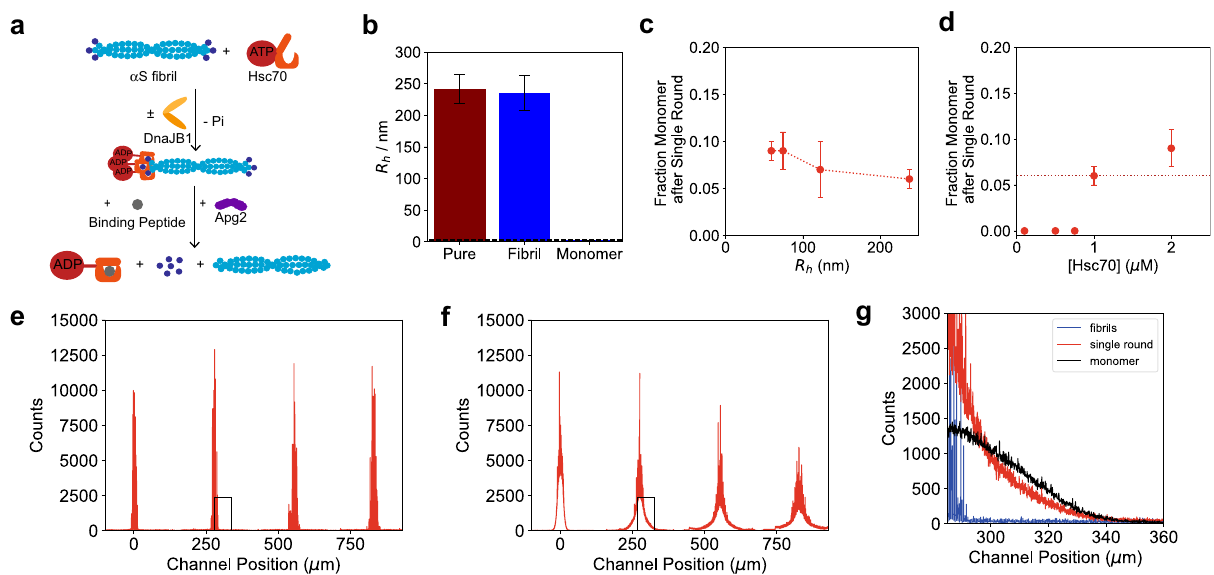
Fig. 4 Single round disaggregation experiments. a To measure the outcome of a single disaggregation round, α S fi brils (2 µ M monomer equivalent) were incubated with Hsc70 and DnaJB1. Subsequently, a 200-fold molar excess of Hsc70-binding peptide GSGNRLLLTG was added, to block Hsc70 re-binding to fi brils. b Outcome of a single disaggregation round, as measured by epi fl uorescence detection. Two species were detectable, the larger of which had a similar size to the initial fi bril, the second of which had the size of monomer. Red represents pure fi brils, blue the outcome after a single disaggregation round. c Fraction of monomer generated as a function of fi bril length at constant α S concentration, corresponding to an increased number of fi bril ends. Shorter fi brils lead to more monomer release per single disaggregation round than longer fi brils, whereby this effect plateaus for fi brils longer than 100 nm. d Fraction of monomer measured at different Hsc70 concentrations. No disaggregation took place for Hsc70 concentrations below 1 µ M, suggesting that there is a critical Hsc70 concentration required for ef fi cient disaggregation. Data in b – d are represented as mean ± standard deviation of n = 3 independent experiments. e Diffusion pro fi le for confocal scanning across the micro fl uidic channel for pure α S fi brils. The pro fi le does hardly broaden, as expected for a large amyloid fi bril. f Diffusion pro fi le for confocal scanning across the micro fl uidic channel after a single disaggregation round. This leads to signi fi cant broadening, whilst the burst height remains similar, indicating that fi brils of similar length and a small species are generated. g Comparison of the signal of pure fi brils (blue), single round disaggregation (red) and pure monomer (black). The red signal after a single disaggregation round is the overlay between the two